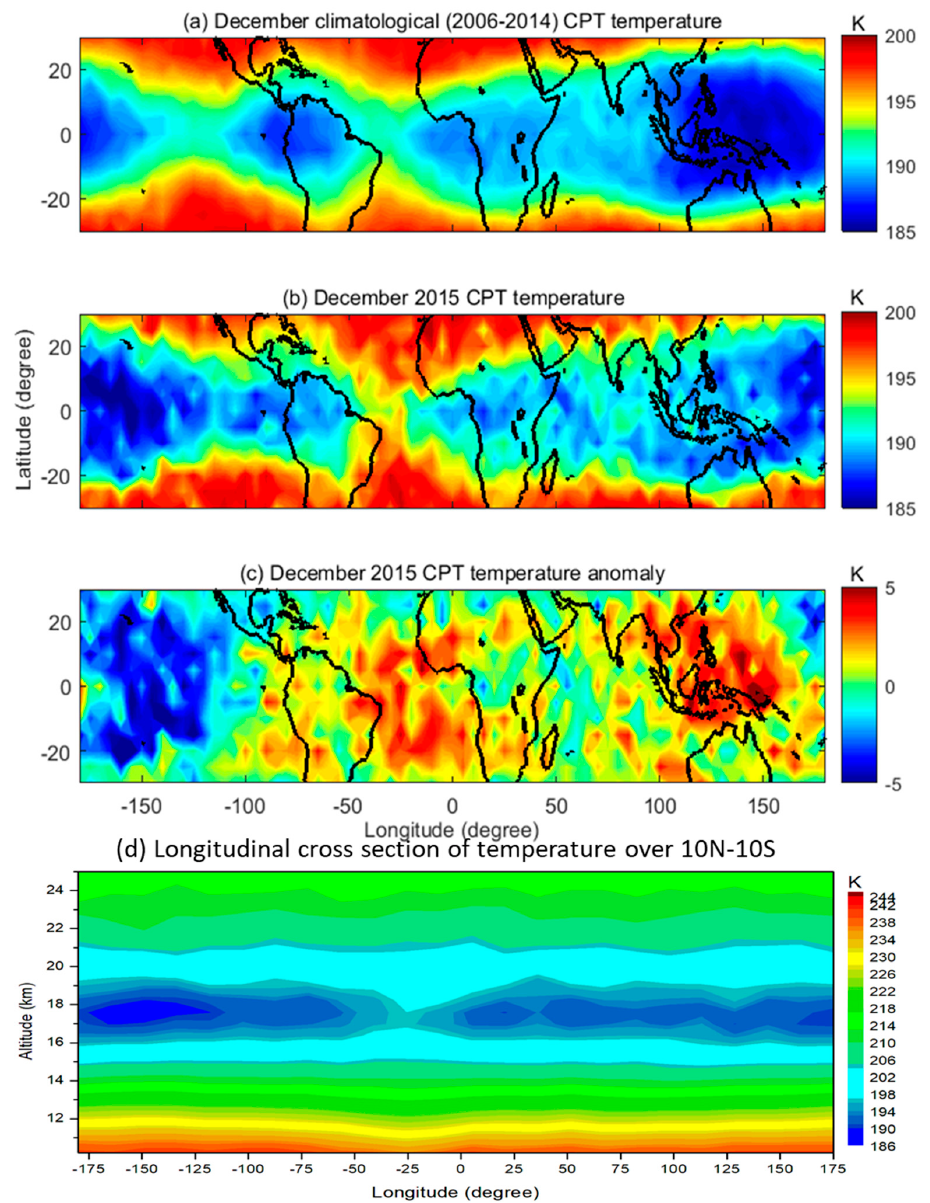
Figure 8. Spatial distribution of COSMIC GPS RO observed cold point tropopause temperature ( a ) December climatological (2006–2014) CPT, ( b ) December 2015 CPT and ( c ) December 2015 CPT anomaly. ( d ) Height-longitudinal cross section of COSMIC temperature over 10 ◦ N–10 ◦ S in December 2015.